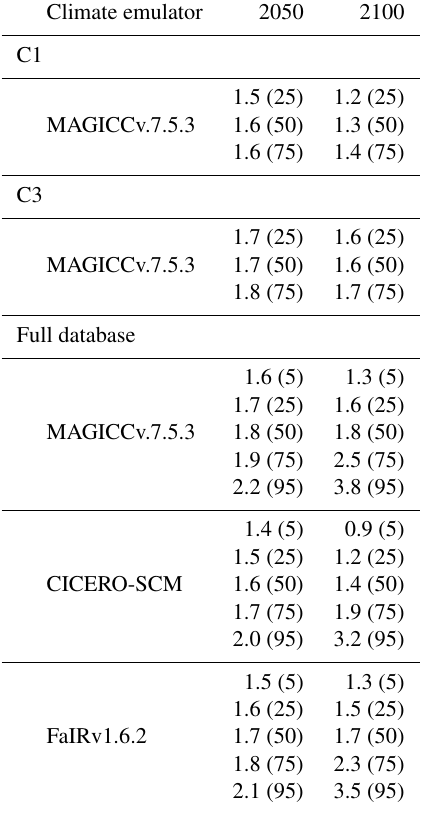
Table 3. Median global temperature statistics of the full scenario database, by climate model, with the percentiles over the scenarios in parentheses for each